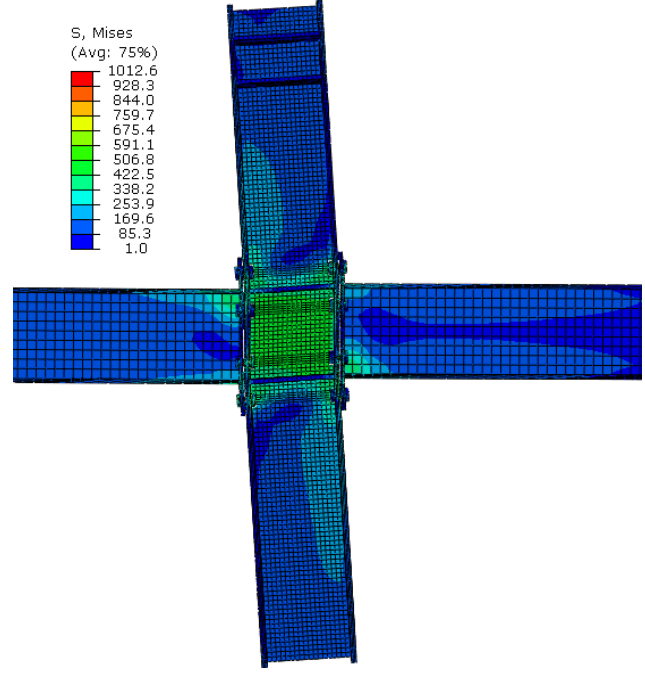
Figure 5. Model stress distribution.